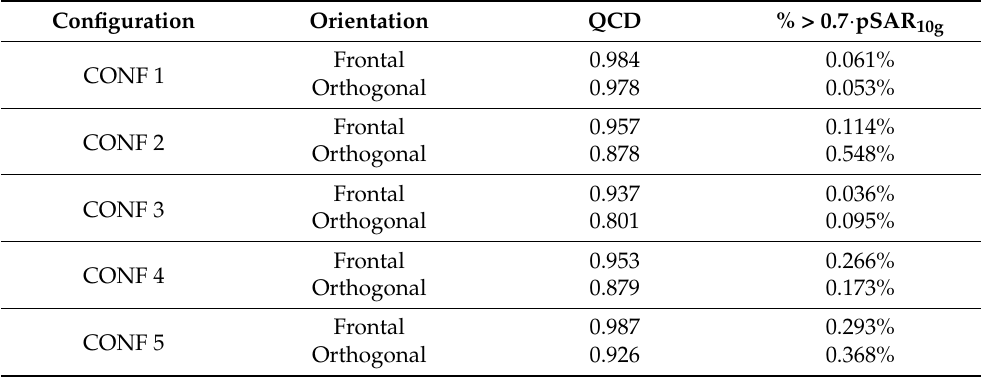
Table 1. pSAR 10g of each configuration for the skin